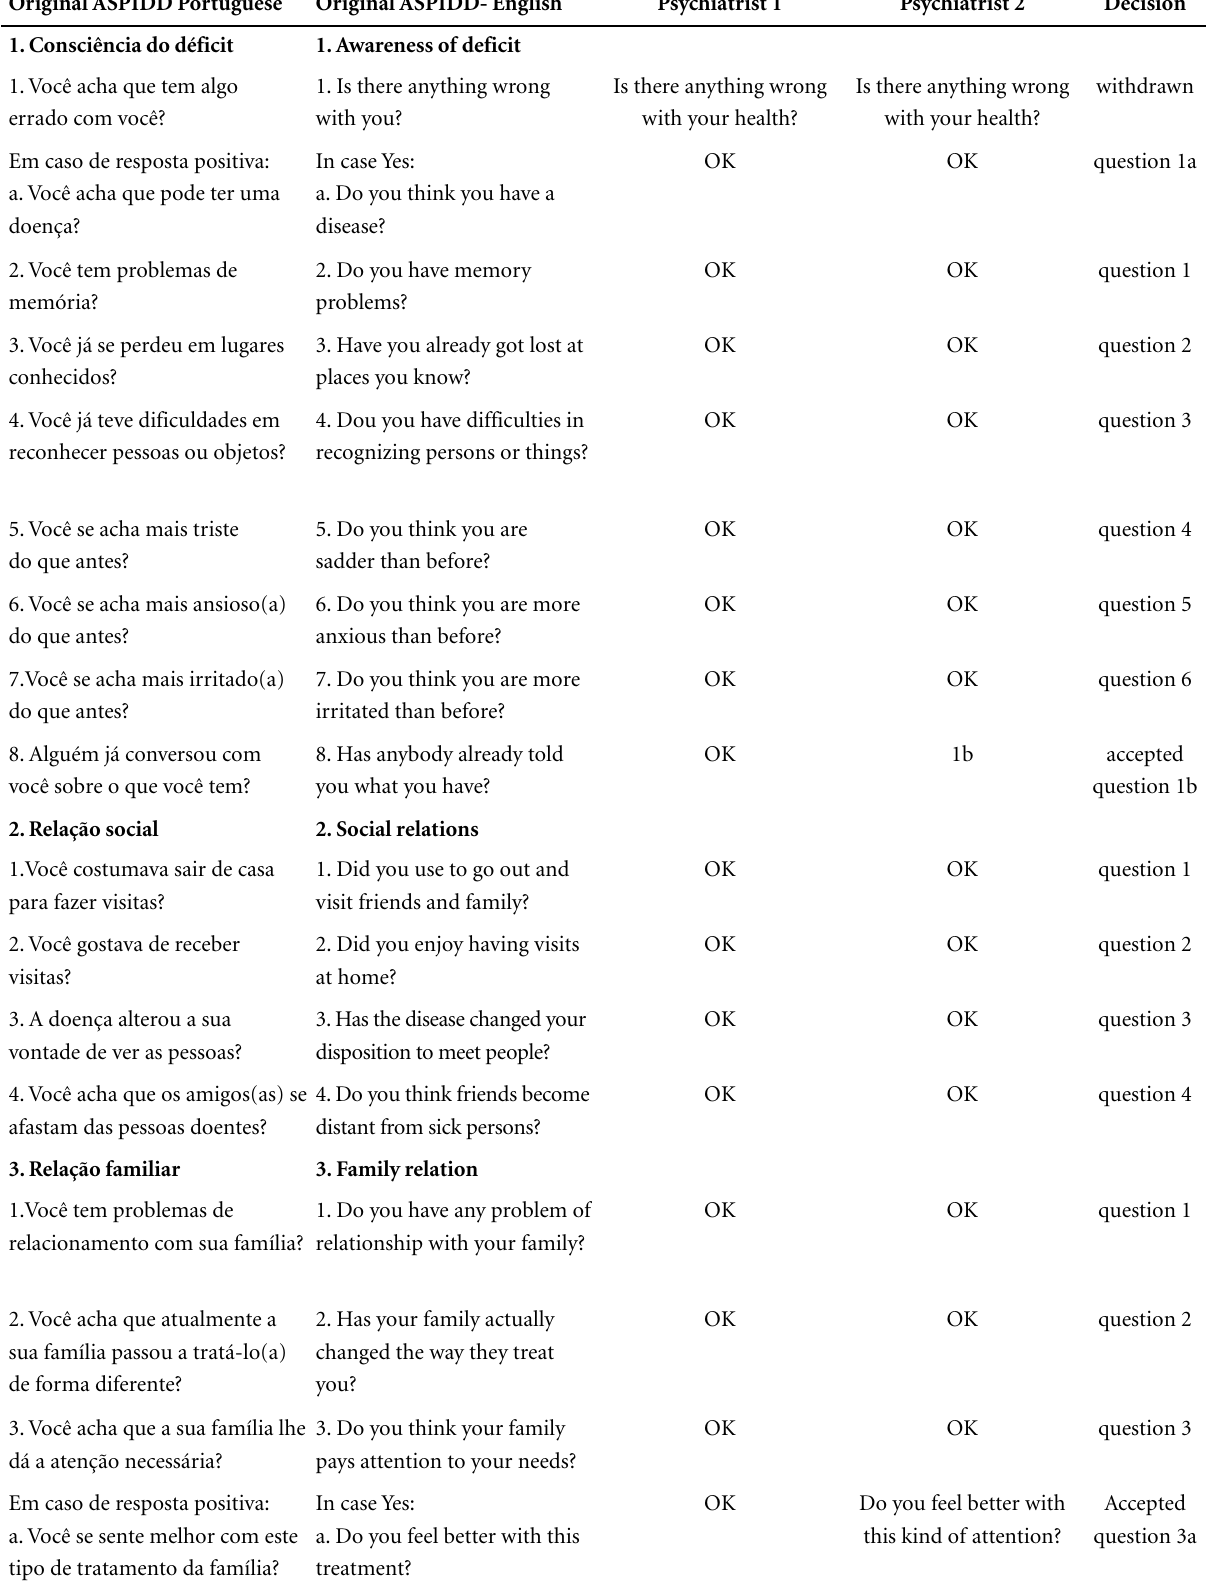
Table 1. Assessment scale of psychosocial impact of the diagnosis of dementia (ASPIDD). Original ASPIDD